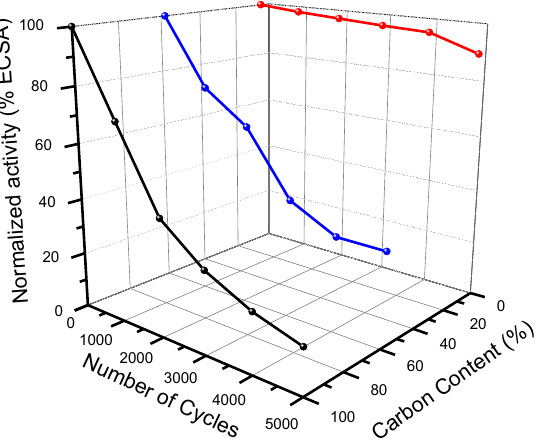
Figure 3. Normalized activity of Pt/C (black), Pt/Mo 2 C/C (blue), and Pt/Mo 2 C (red) as a function of the number of accelerated test cycles and carbon